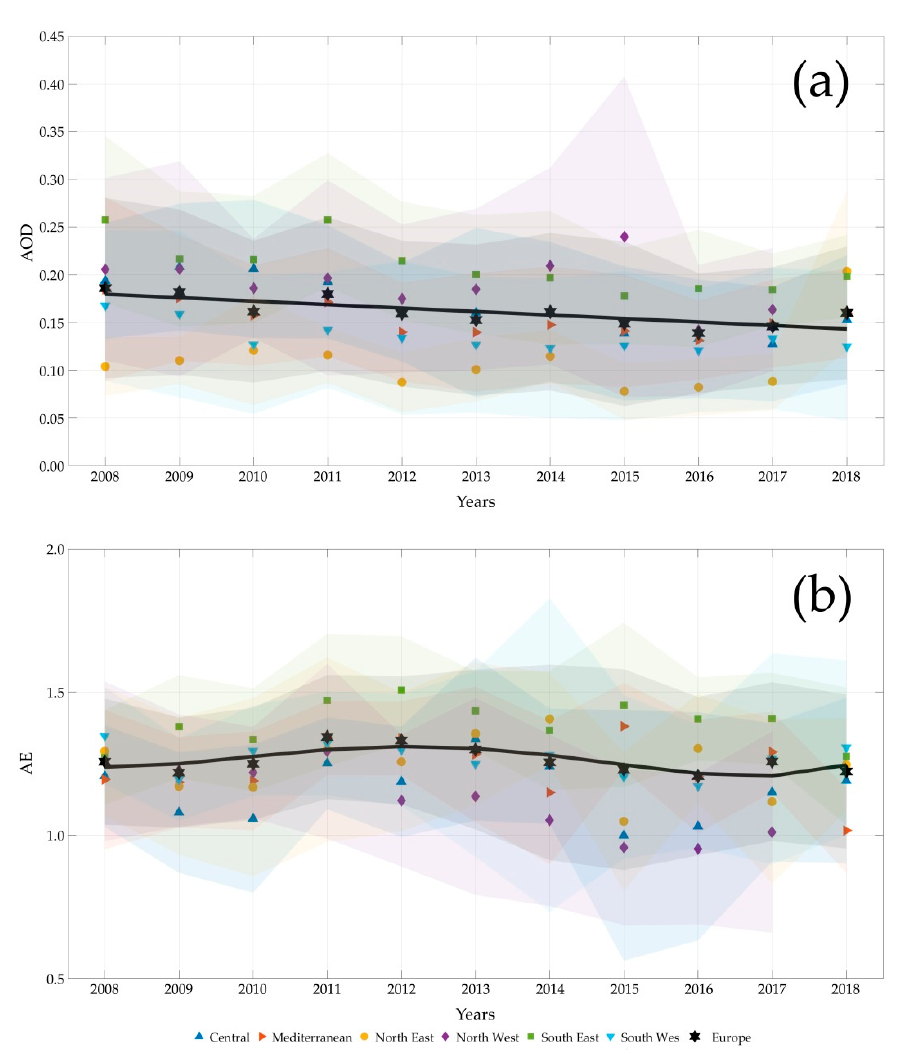
Figure 7. Changes in the aerosol optical properties over Europe between 2008 and 2018 as measured by AERONET photometers: ( a ) time evolution of the aerosol optical depths (500 nm); ( b ) time evolution of the Angstrom exponents (380 / 500 nm). Black lines represent the linear and fourth-grade polynomial fit of the European mean values, and the shaded areas represent the standard deviations.